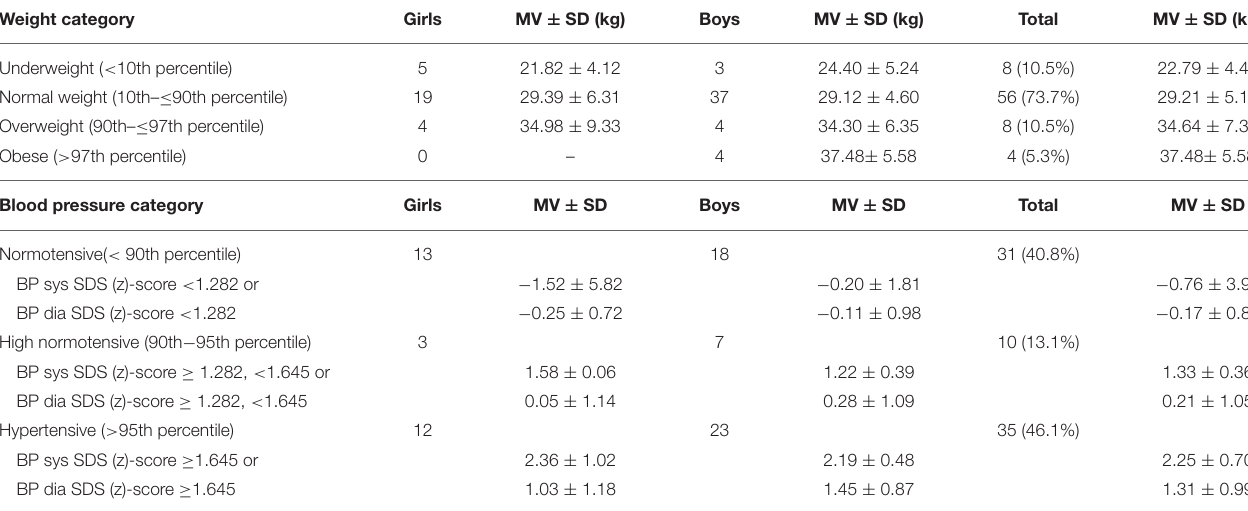
TABLE 3 | Descriptive analysis of the studied population according to weight categories and blood pressure categories. Weight category